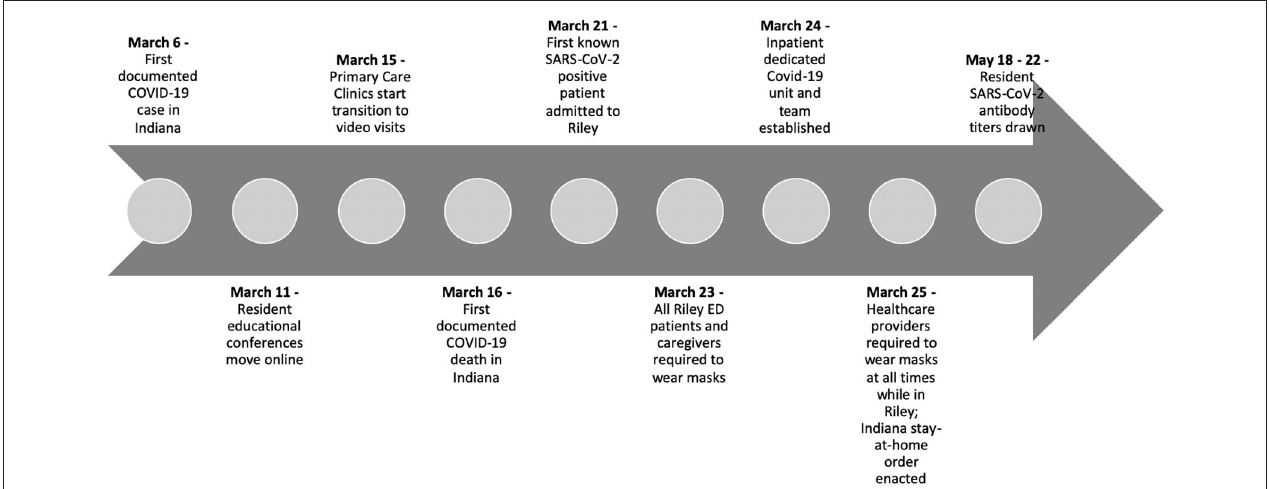
FIGURE 2 | Timeline of Riley children’s hospital’s response to SARS-CoV-2.